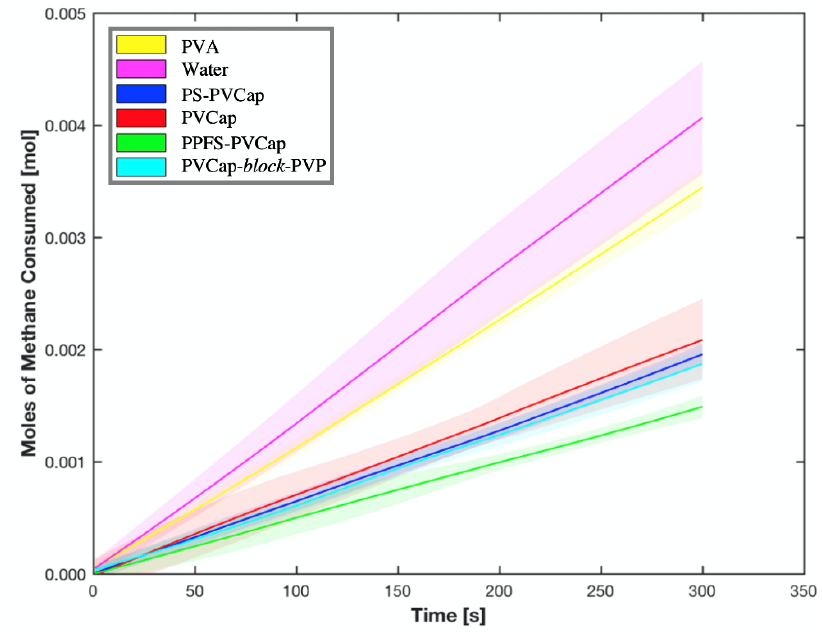
Figure 9. Initial growth rate of methane hydrates in water with PVA, PVCap, PS-PVCap, PPFS- PVCap, andPVCap-PVP block copolymer surfactants. The shaded area corresponding to each color is the 95% confidence interval for each polymer; 5–10 replicates of each experimental conditions were performed.